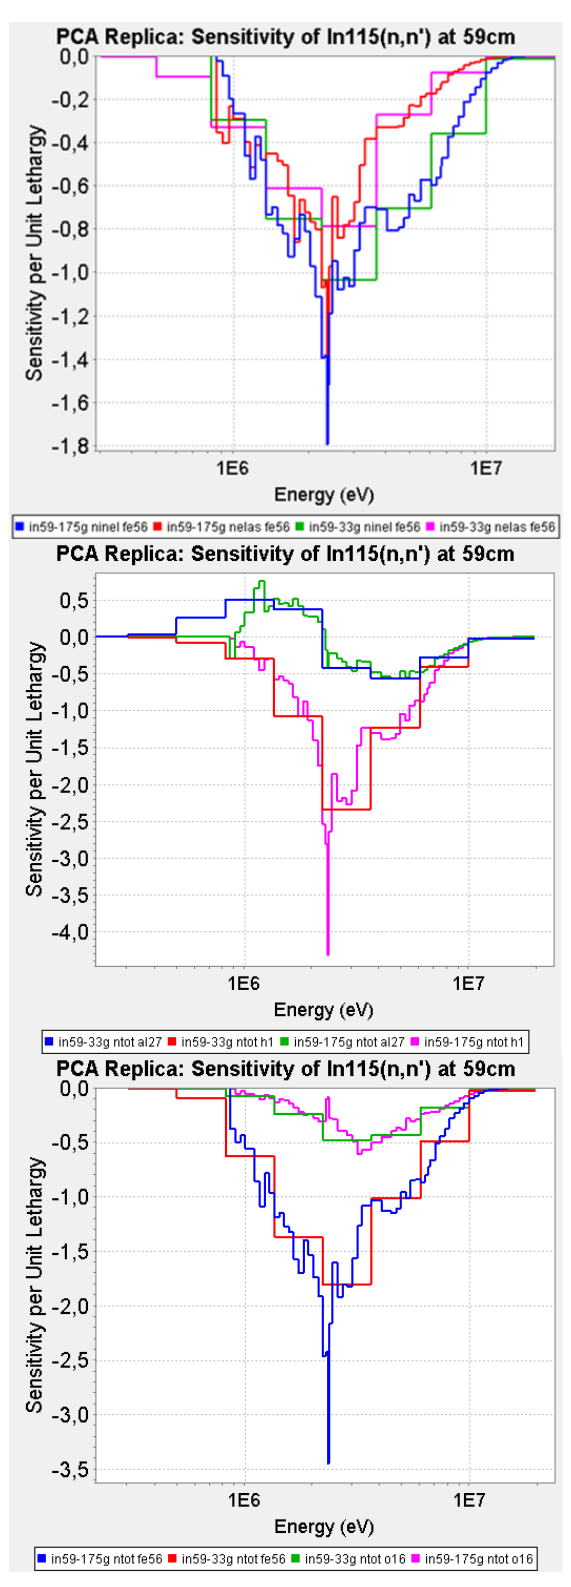
Fig. 3. Comparison of the sensitivity profiles for the reaction rates measured in the ASPIS PCA Replica benchmark. The sensitivities were obtained using the 175- and 33- energy group nuclear data.